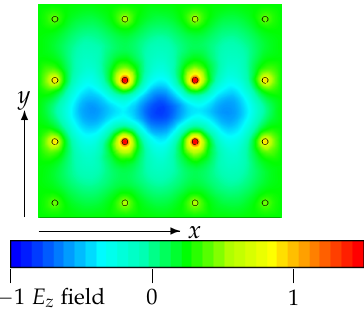
Figure 5. Longitudinal E z component on the ( x , y ) plane cutting across a 4 × 4 array of uniform infinitely long wires in a waveguide. The distances between the wires are given by L x = 15.0 mm and L y = 13.06 mm. The dimensions of the waveguide are given by S x = 52.5 mm and S y = 45.71 mm. Thus, the distances of the wires closest to the waveguide walls and the walls are 1 the data for our preferred longitudinal mode, which is only one of many.